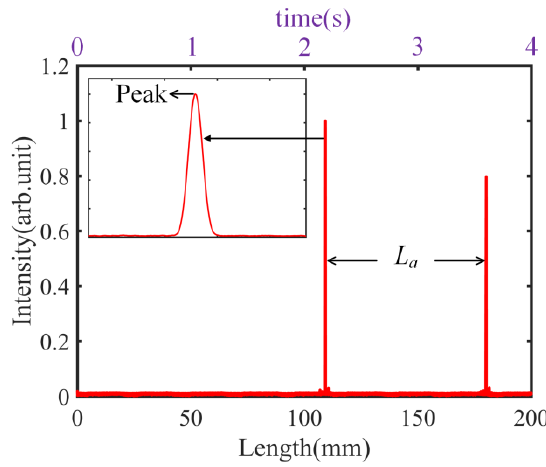
Figure 4. Results of Hilbert transform.